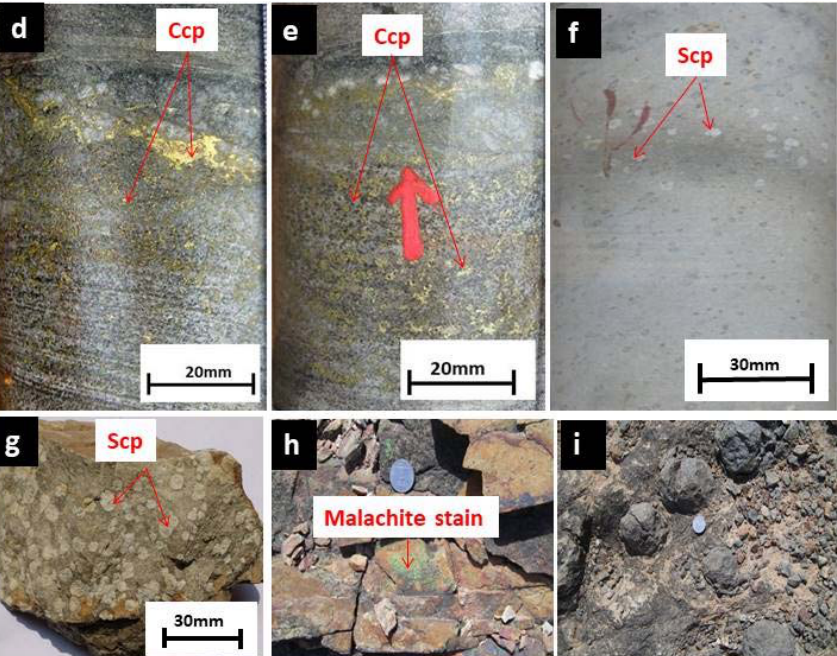
Figure 5. Field photographs showing ( a ) foliation parallel and vein (quartz-carbonate) filled chal- copyrite in felsic meta-volcanic rock; ( b ) pyrrhotite and chalcopyrite occurring as veins within felsic volcanic rock; ( c ) arsenopyrite as layers within the coarse grained felsic volcanic rocks; ( d , e ) stringers and disseminations of chalcopyrite in the coarse grained altered part of the meta-volcanic rock; ( f ) scapolite (white patches) in the highly altered felsic tuff; ( g ) scapolite (as white patches) in the fine grained and pervasive felsic volcanic rock; ( h ) Surficial malachite stains on volcanic tuff; ( i ) spheroidal weathering exhibited by rhyolite. (Apy: Arsenopyrite, Ccp: Chalcopyrite, Po: Pyrrhotite and Py: